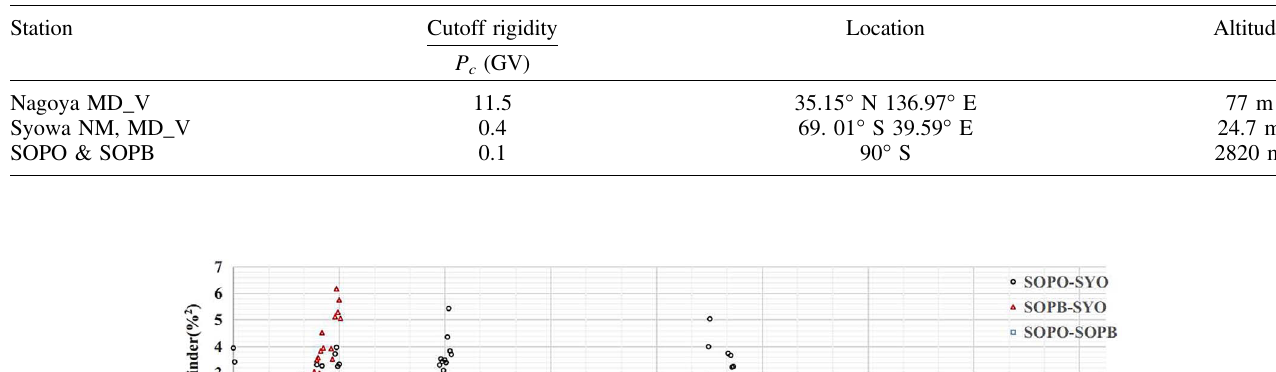
Table 2. Geographic location and cut off rigidity of Nagoya MD, Syowa MD & NM, SOPO, and SOPB. P c of SyowaNM and MD is calculated for vertical